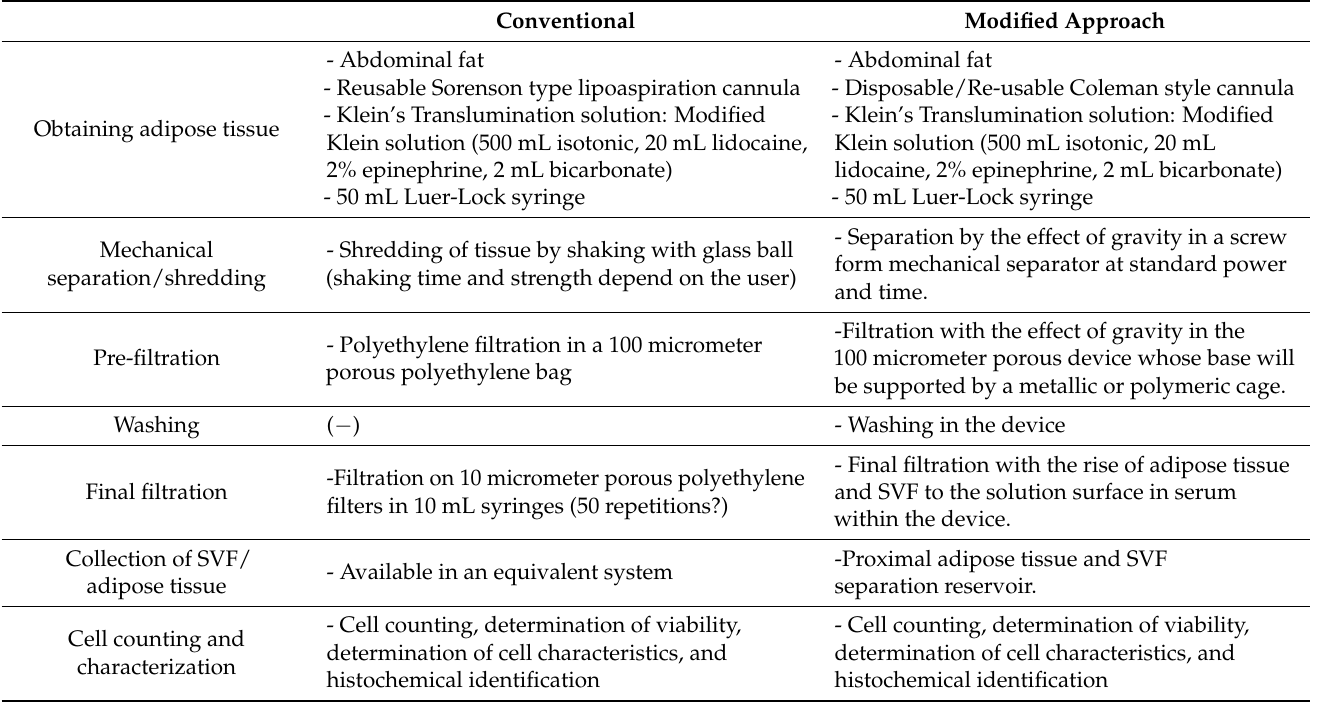
Table 4. Steps of Stromal Vascular Fraction Separation